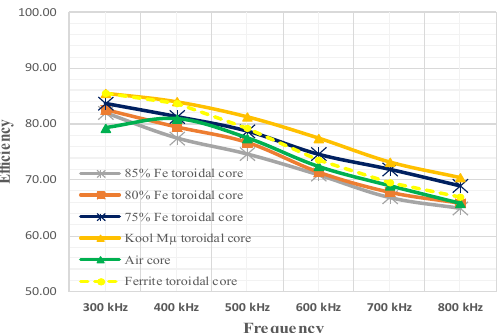
Figure 24. Efficiency in the resonant converter with inductors using different magnetic cores.